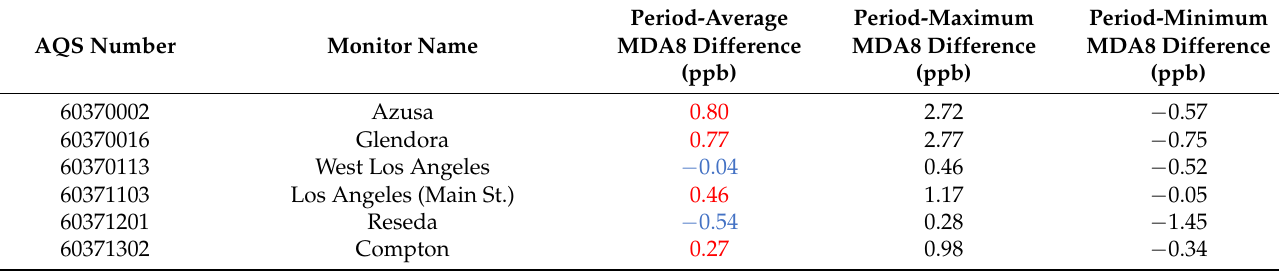
Table 3. CMAQ impacts of the ozone response to COVID-19 emissions reductions at the SOCAB